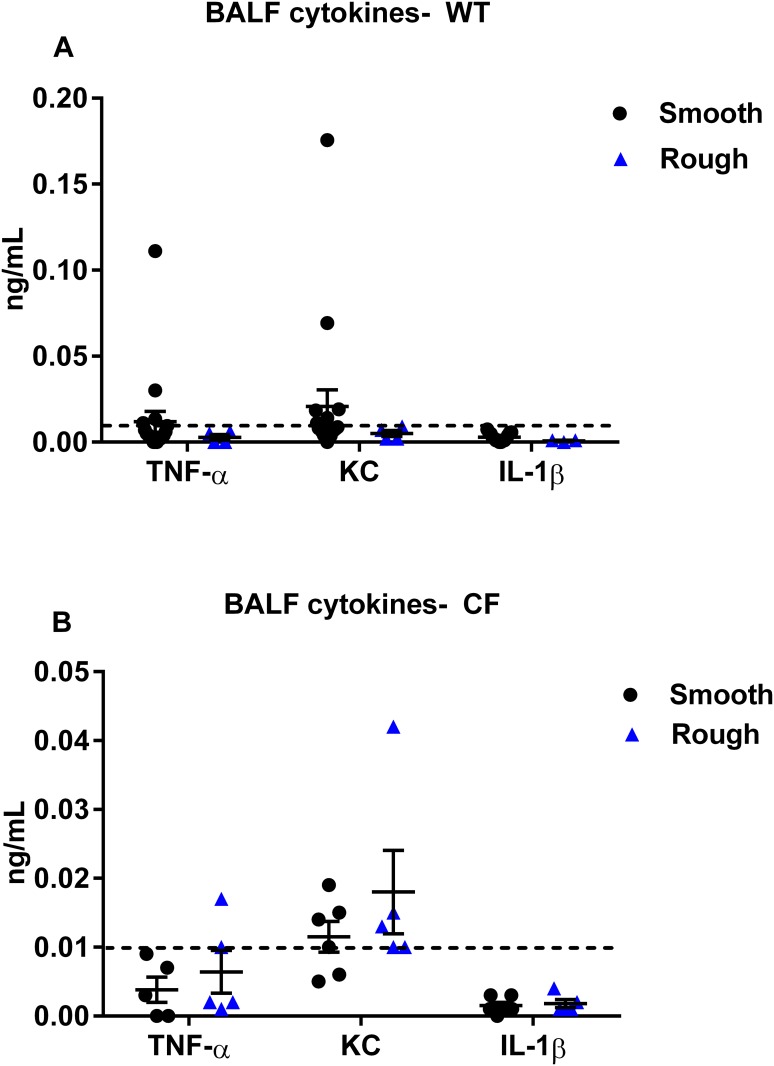
BALF cytokines.(A and B) BALF cytokines 3 days post-inoculation did not differ between groups. (N = 3–18 in each WT group, N = 5–6 in each CF group). Data displayed as mean ± SEM of group, pooled from 2–3 replicate experiments for each morphotype. Dashed line indicates lower limit of detection of kit.